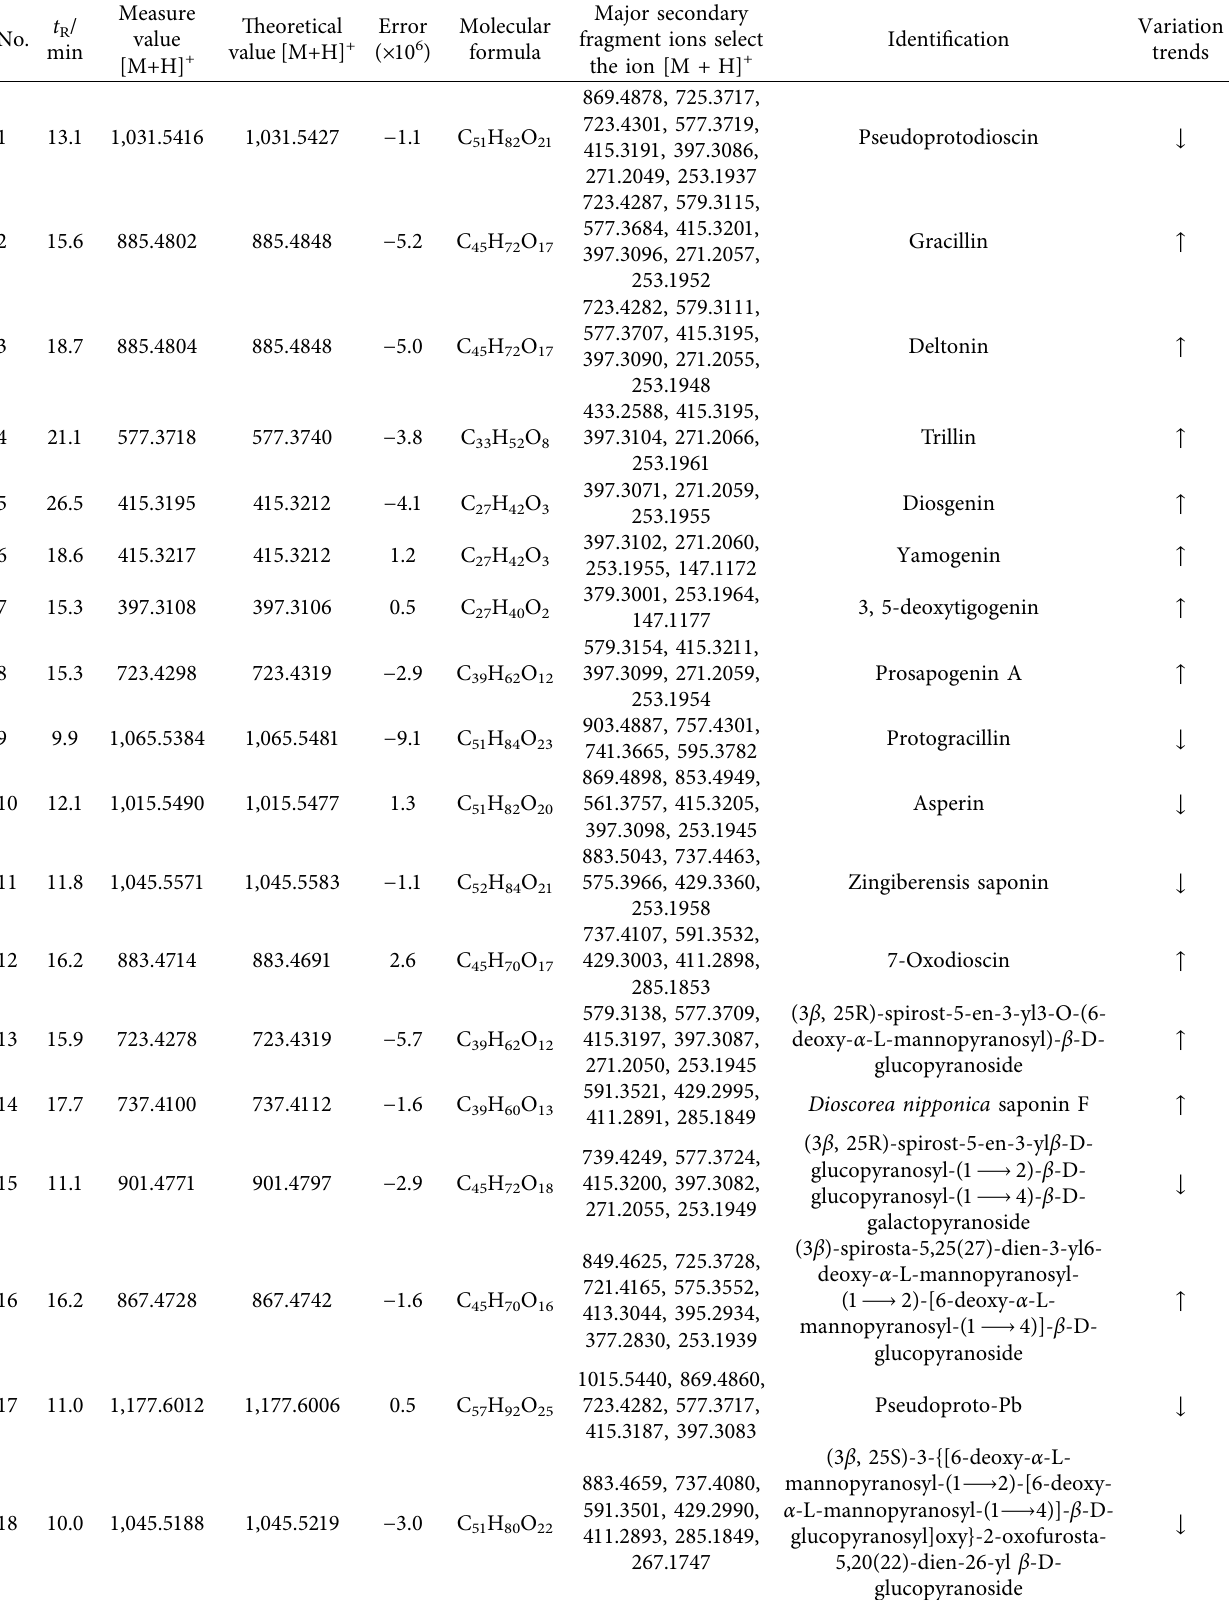
Table 2: Identification results and the trends of saponin components in the analyzed